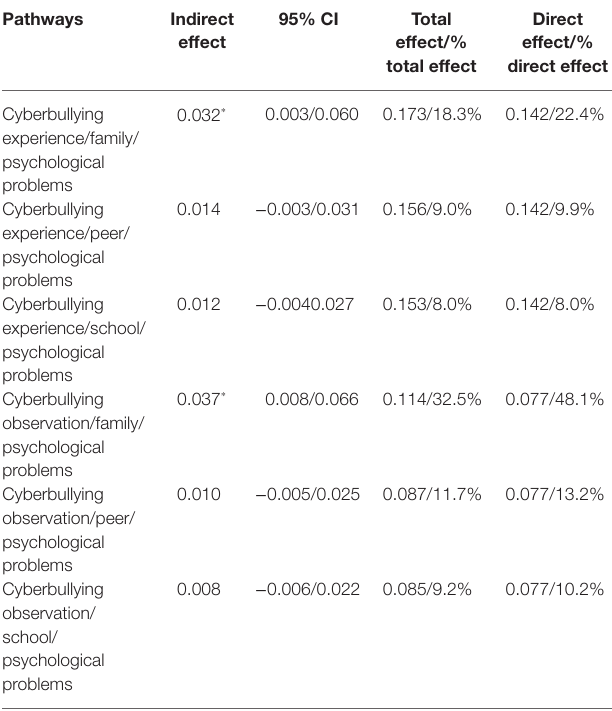
TABLE 6 | Standardized indirect effects of cyberbullying experience and observation on psychological well-being outcomes via social support.